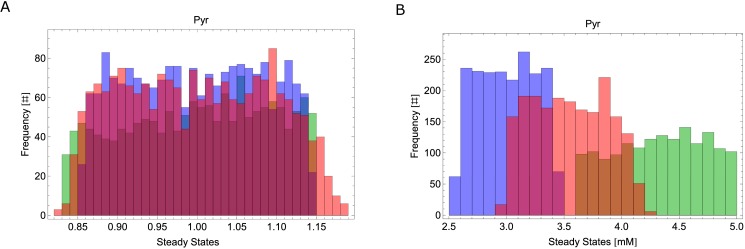
Robustness to uncertainty and branch deletion.Histogram accounting for uncertainty and branch deletion at the level of Pyr steady state. Blue bars represent the histogram of Pyr production when the npED branch is set to zero (NP = 0), green bars represent the histogram of Pyr production when the spED branch is set to zero (SP = 0), and red bars represent the histogram of Pyr production for the wild type (WT). A) Relative steady state values. B) Absolute steady state values. # represents counts.